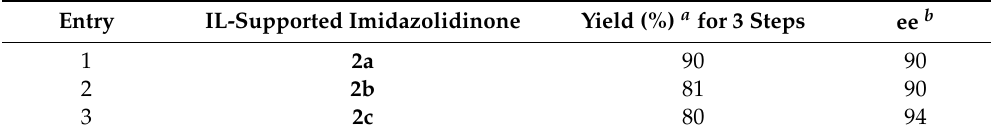
Table 2. Yields and enantiomeric excess (ee) of ( − )- 15 in ionic liquid ( 2a ‒ c )-supported reactions. a Entry IL-Supported Imidazolidinone